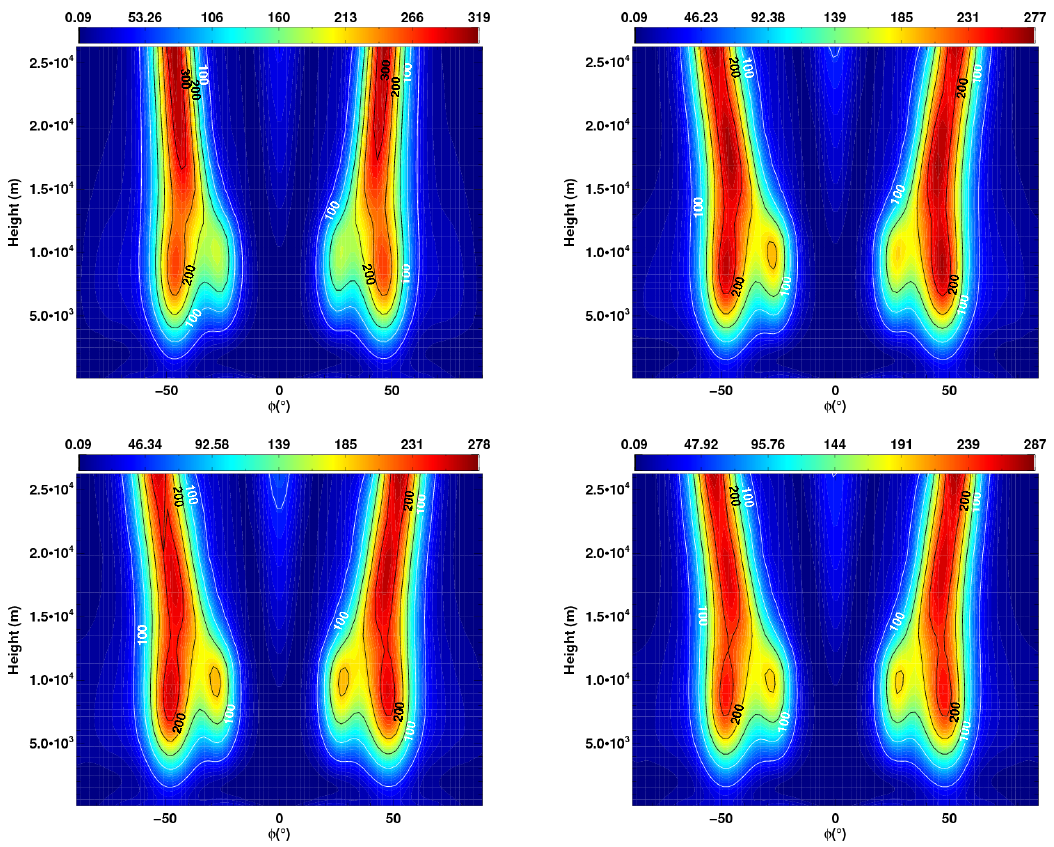
Figure 11. Figure, for the Earth-like test (Menou and Rauscher, 2009), showing the zonally (in geometric height) and temporally averaged EKE (see Sect 3.1) as a function of latitude and height. Top left panel: ND, top right panel: EG sh , bottom left panel: EG gc and bottom right panel: EG models (see Table 2 for explanation of model types). Note the contours (solid lines) are the same in all plots.